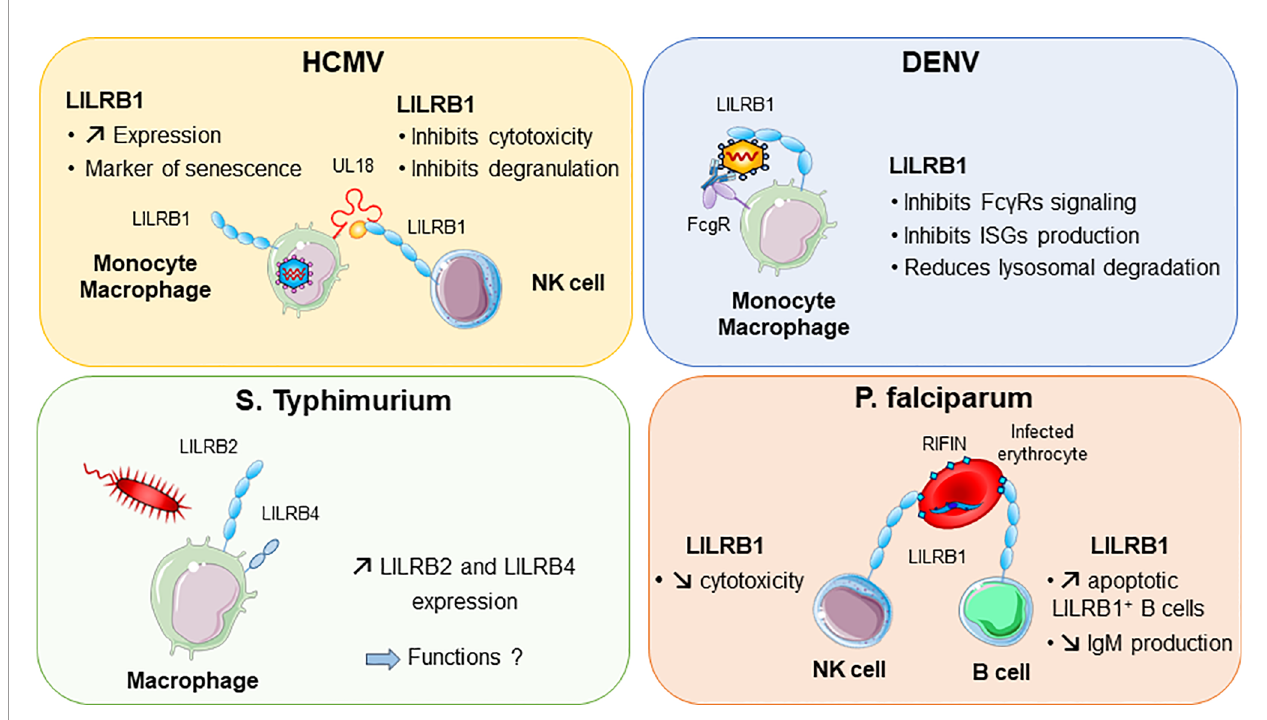
FIGURE 4 | LILRB1 and LILRB2 implication in various infectious diseases. Human cytomegalovirus (HCMV, in purple) produces UL18 protein that binds to LILRB1 with high af fi nity and regulates NK cell functions. Dengue virus (DENV in blue) can directly bind to LILRB1 expressed by monocytes and macrophages. This interaction inhibits the production of interferon (IFN)-stimulated genes (ISG). In red, Plasmodium falciparum produces RIFINs in infected erythrocytes. Binding of RIFINs to LILRB1 inhibits NK cell cytolytic activity and production of IgM by B cells. Exposure of macrophages to S. typhimurium bacteria promotes the upregulation of LILRB2 and